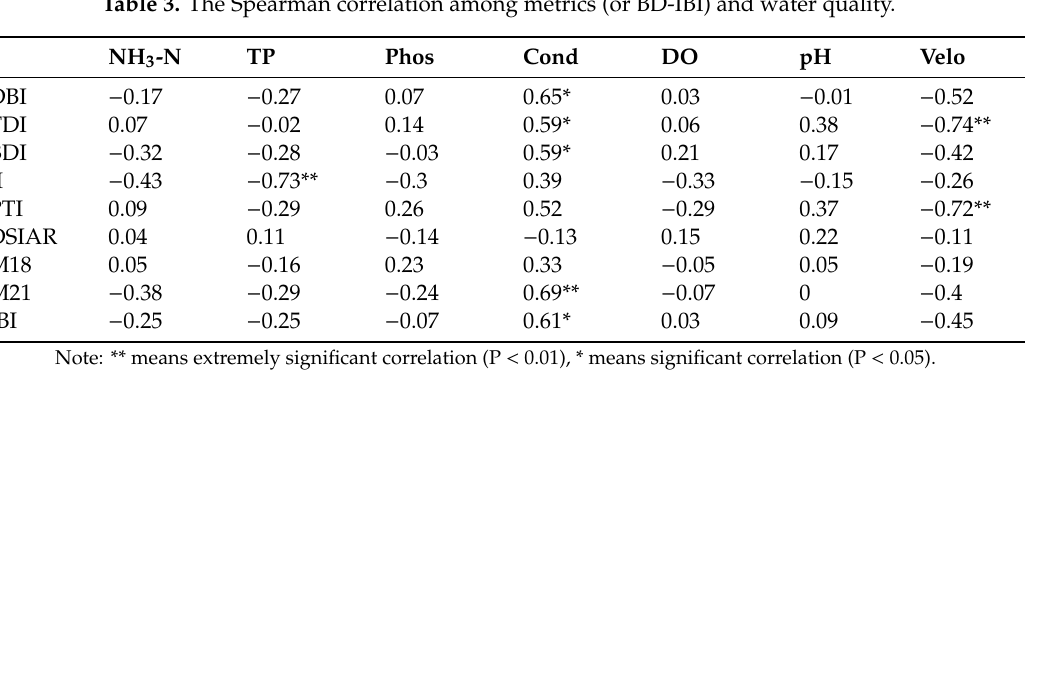
Table 3. The Spearman correlation among metrics (or BD-IBI) and water